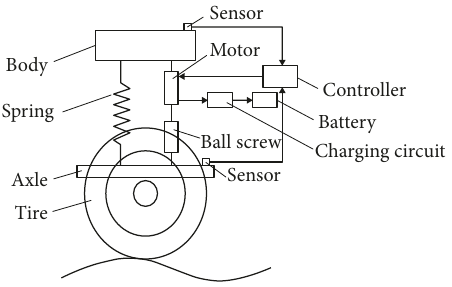
Figure 1: Structure of the EERAS